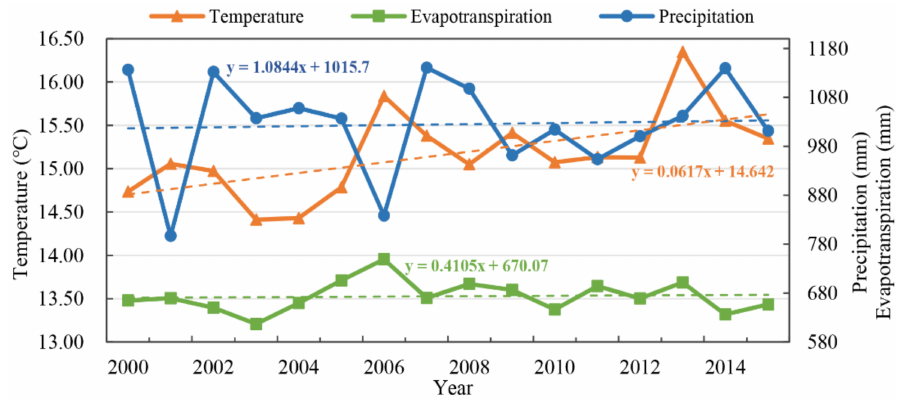
Figure 9. Changes in the air temperature, precipitation and evapotranspiration in the TGRC from 2000 to 2015.